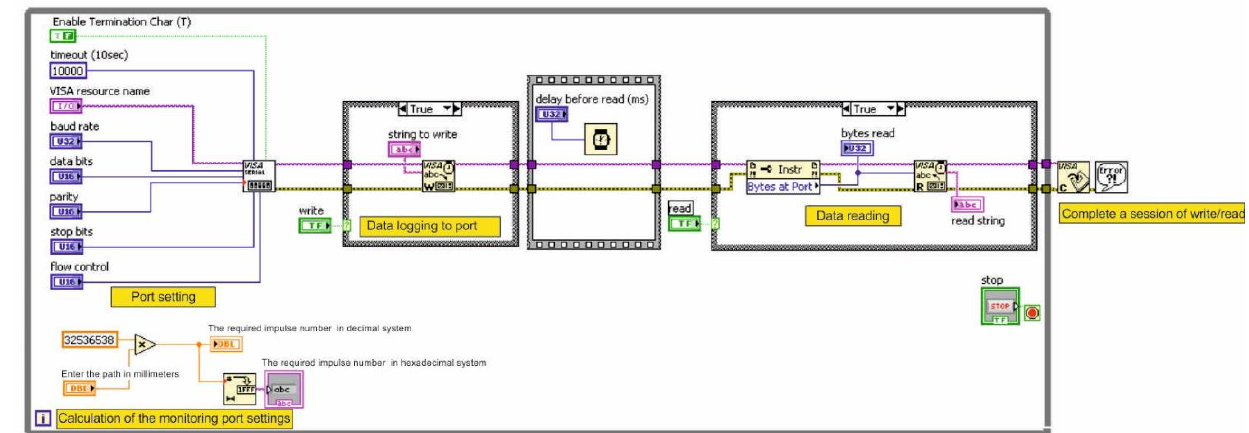
Figure 4. Block diagram of the slave motor monitoring system in the environment